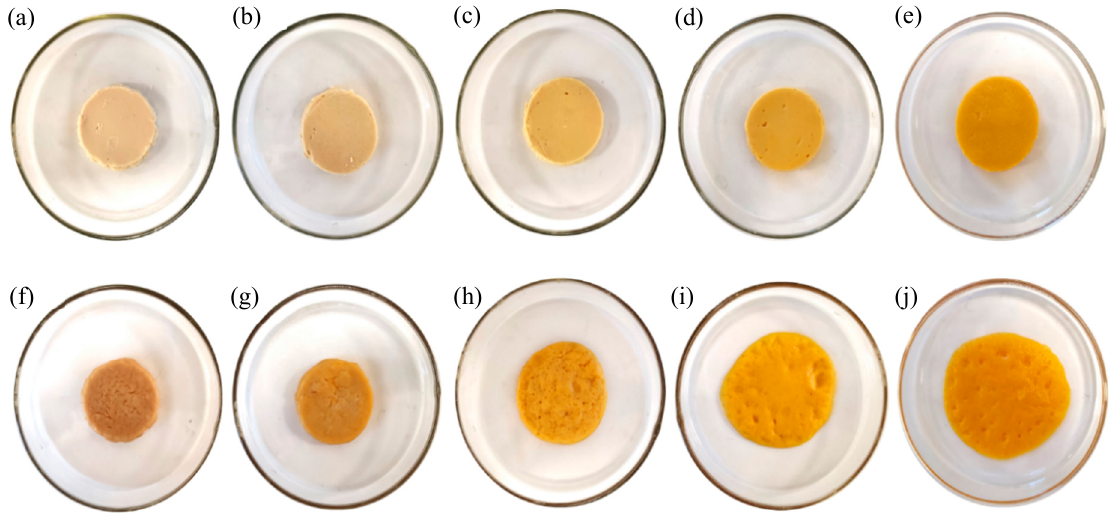
Figure 5. Photographs of plant-based cheese alternative samples, 0Z-100C, 25Z-75C, 50Z-50C, 75Z- 25C and 100Z-0C before ( a – e ) and after ( f – j ) oven heating at 232 °C for 5 min.